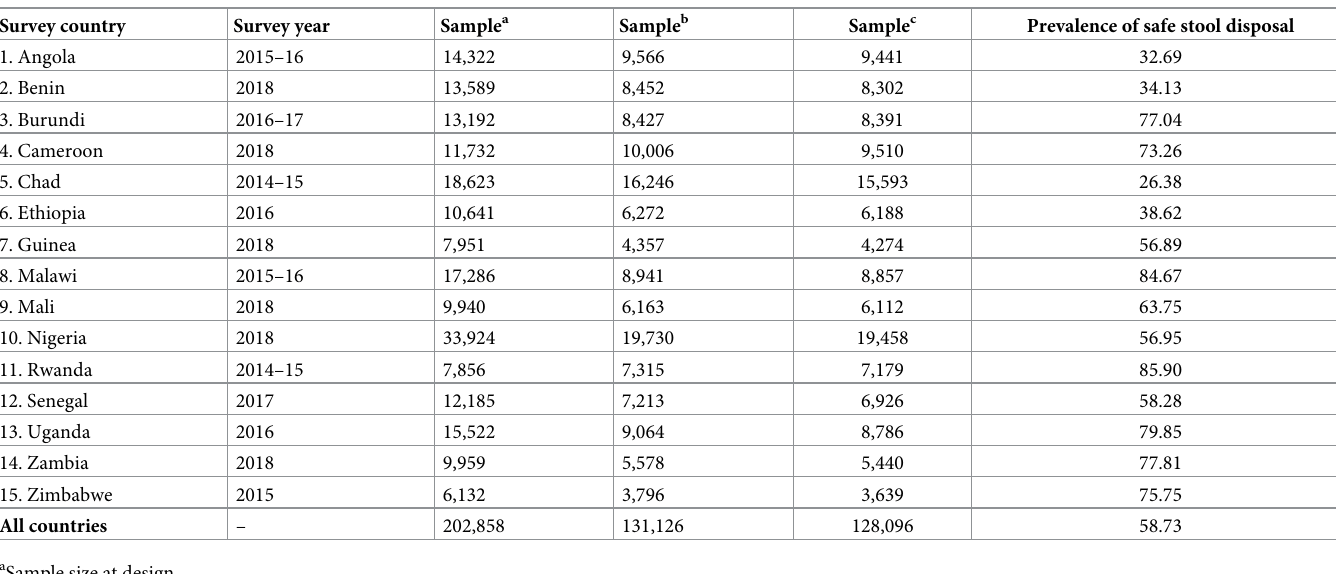
Table 1. Description of study sample and prevalence of safe stool